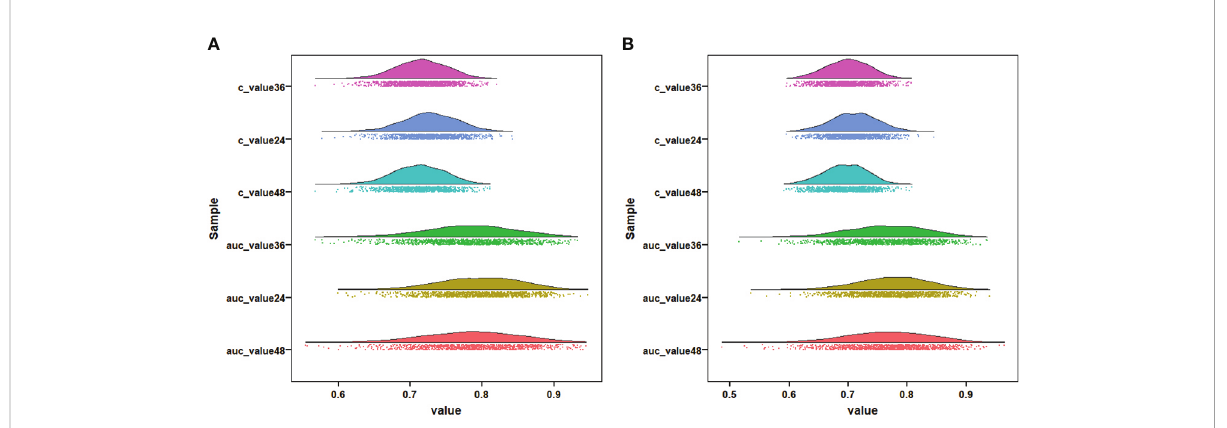
FIGURE 7 Visualization of the result of k-fold cross-validation (k = 10) through with half violin plot, scatter plot, and boxplot with median. Part (A) is for OS analysis and part (B) is for CSS analysis.